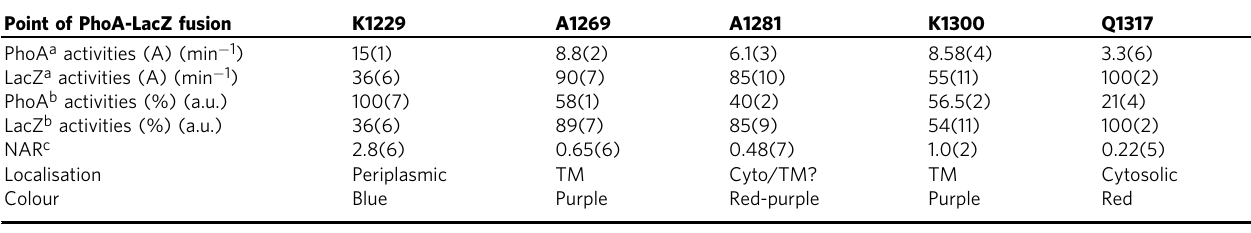
Table 1 Quanti fi cation of PhoA-LacZ enzymatic activities in permeabilised E. coli DH5 α cells expressing Tse5-CT-PhoA-LacZ fusion